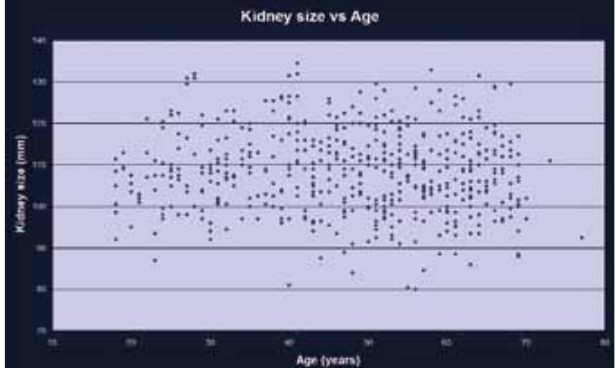
Fig. 7. Kidney size in relation to